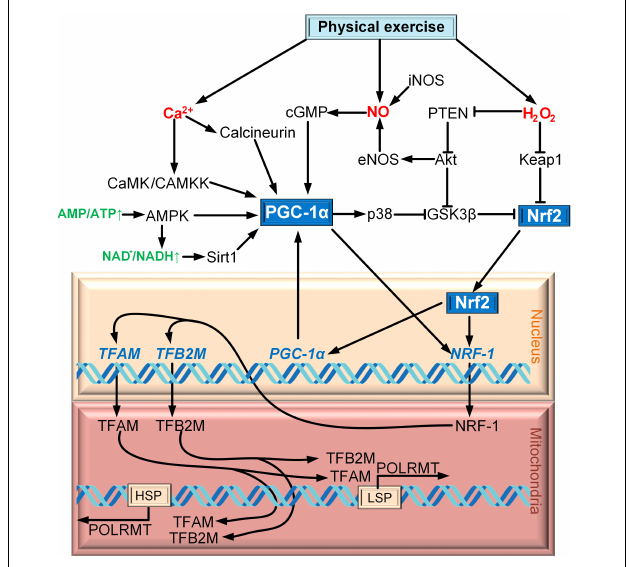
FIGURE 1 | Scheme of interaction between Nrf2 and PGC-1 α on the example of exercise.